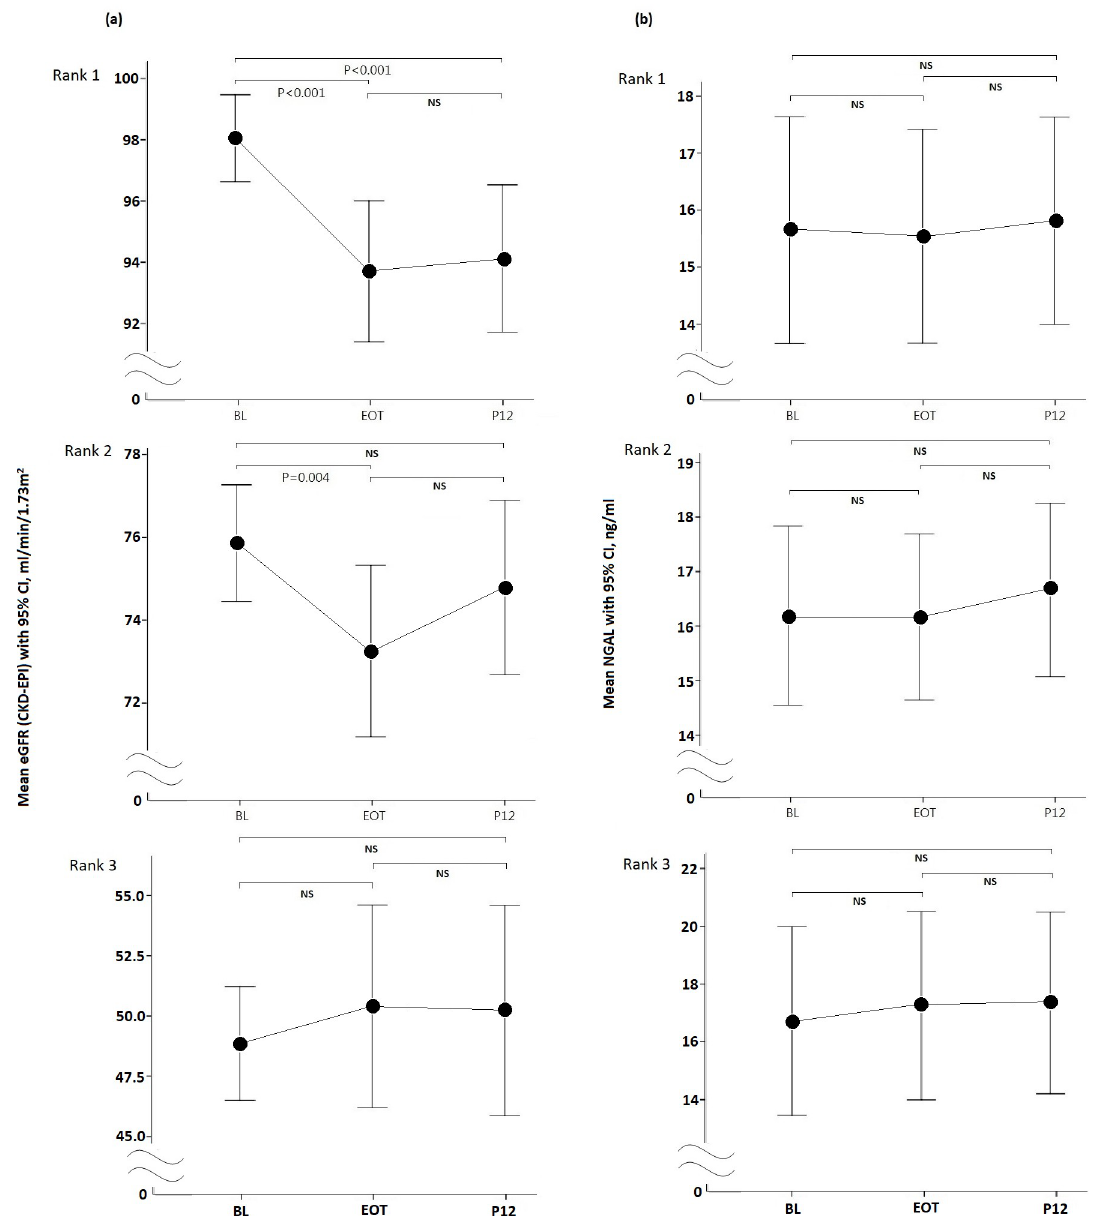
Fig 4. The eGFR and NGAL changes from the BL, EOT to P12 in different BL eGFR ranks in CHC patients receiving DAA therapy. a. eGFR; b. NGAL. As shown in Fig 4A, among patients with BL eGFR rank 1, the eGFR was significantly reduced from the BL to EOT and from the BL to P12, but not from EOT to P12 (BL vs. EOT, P < 0.001; BL vs. P12, P < 0.001; EOT vs. P12, P = 0.680). Among patients with BL eGFR rank 2, the eGFR was significantly decreased from the BL to EOT but not significantly different between BL and P12 and between EOT and P12 (BL vs. EOT, P = 0.004; BL vs. P12, P = 0.225; EOT vs. P12, P = 0.086). Among patients with BL eGFR rank 3, the eGFR was not significantly different between the two groups (BL vs. EOT, P = 0.423; BL vs. P12, P = 0.477; EOT vs. P12,